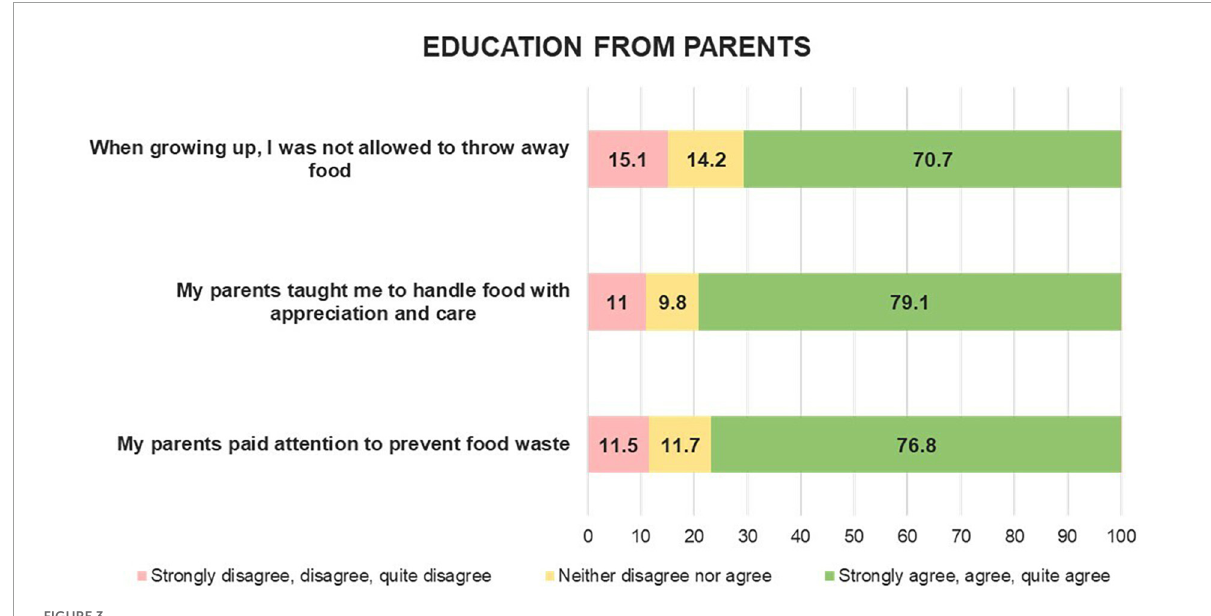
FIGURE3 Education received from parents among the sample. Percentage values